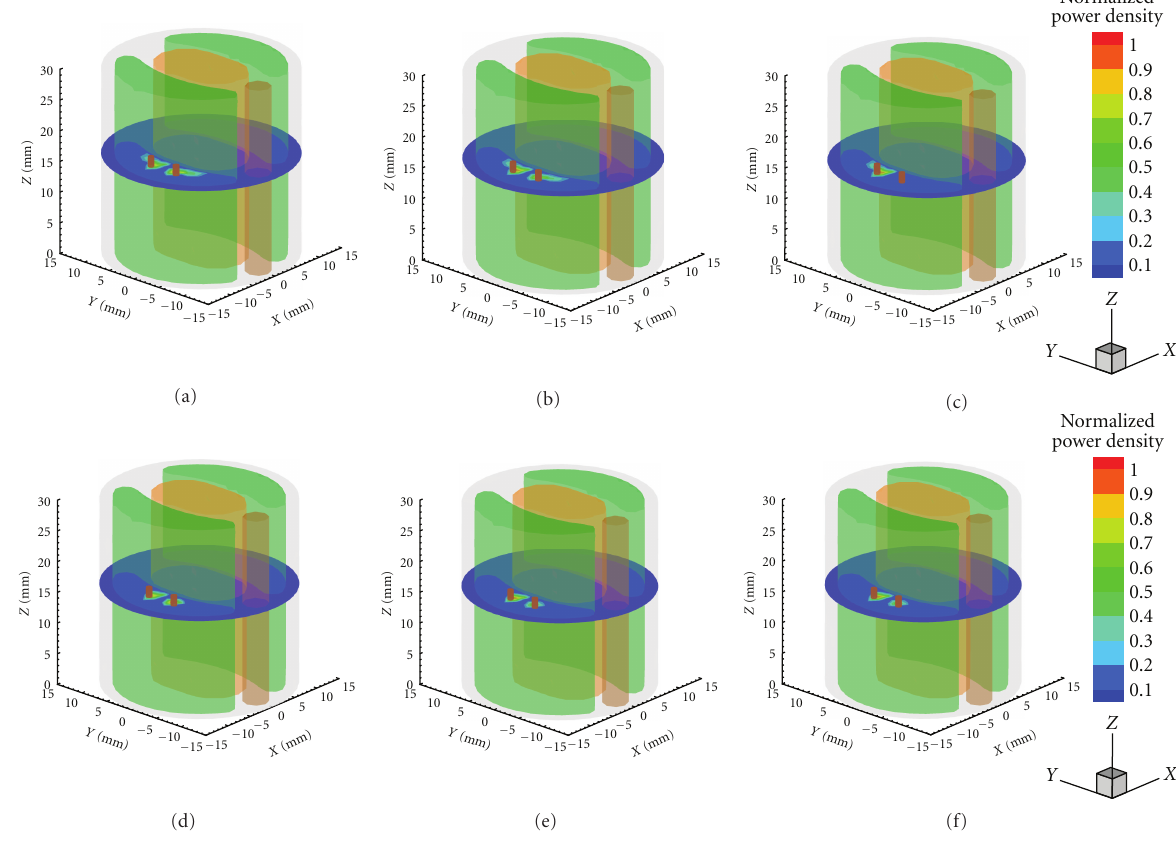
Figure 9: Normalized reconstruction results in phantom experiments. (a)–(c) are the results of Tikhonov + GTS with power ratio of 1:1, 2:1, and 4: 1. (d)–(e) are the corresponding results of Tikhonov +